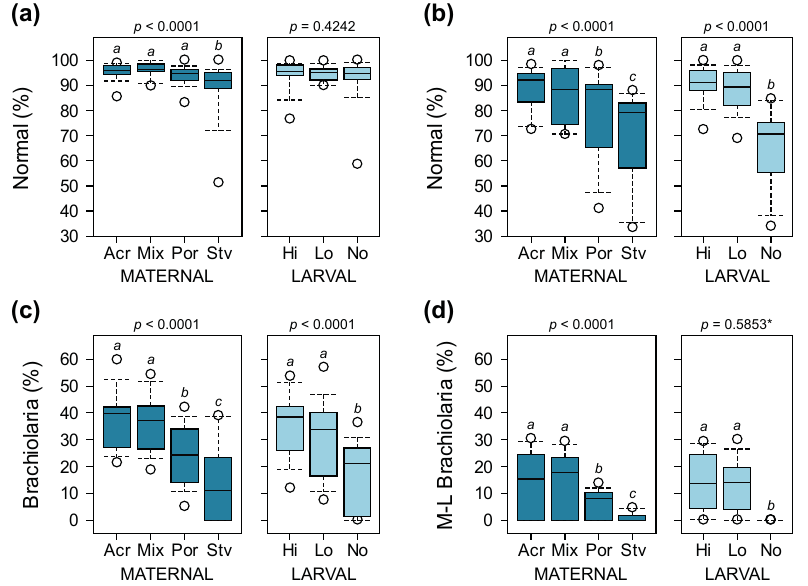
Figure 4. Proportion of normally developing larvae at 8 days ( a ) and 16 days ( b ) after the onset of the ability of larvae to feed, and proportion of larvae at the brachiolaria stage after 8 days ( c ) and larvae at the mid-to-late (M-L) brachiolaria stage after 16 days ( d ). p -values are from overall binomial GLMs and different letters are significantly different based on post hoc pairwise comparisons (* p -value for comparison between high and low algal food treatments only; starved larvae not included in analysis due to zero variance).